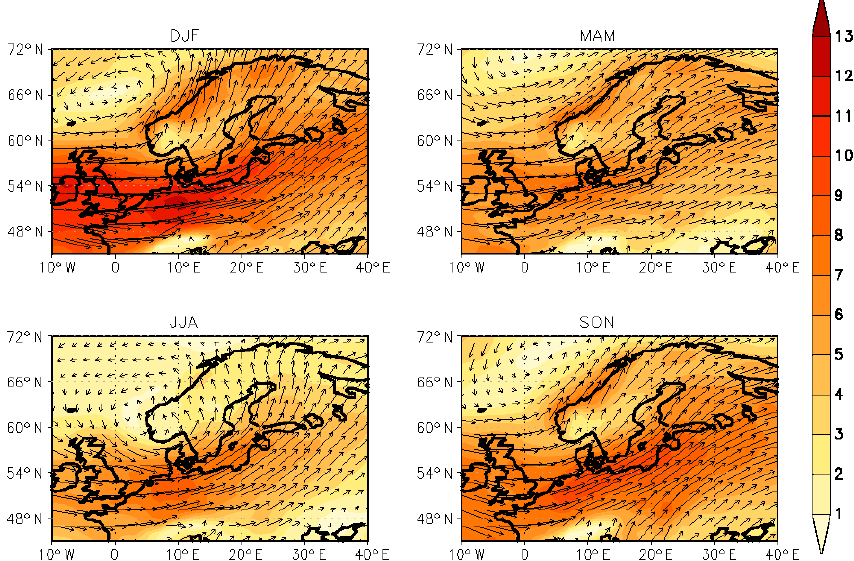
Figure 5. Seasonal average wind strengths and directions at 850hPa showing the dominant circulation pattern observed when NO 2 extreme pollution events